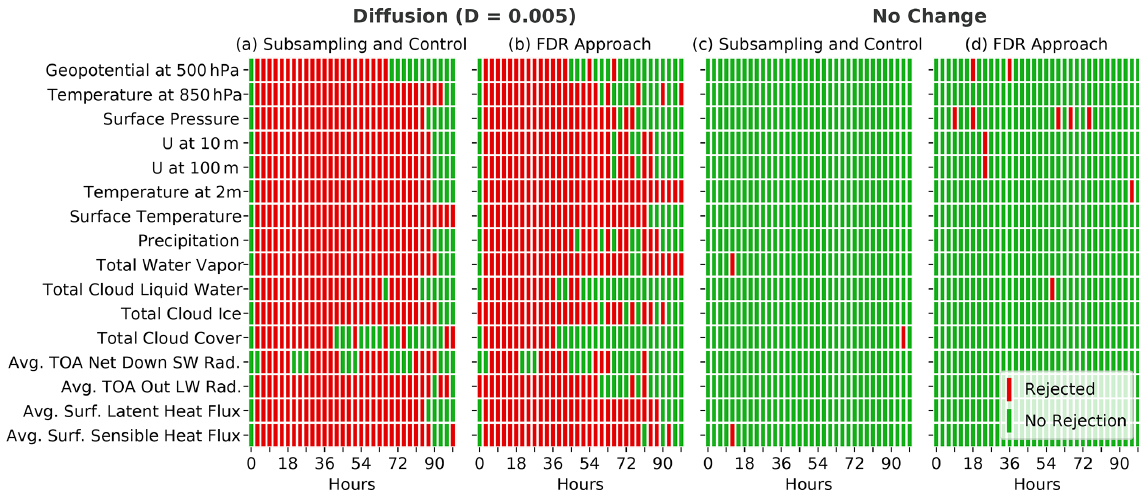
Figure 11. Comparison between our methodology, which uses subsampling ( n E = 100, n S = 50, m = 100) and a control ensemble, and an approach that uses only one comparison between all members of the two ensembles with n E = 100 in combination with the FDR correction and α FDR = 0 . 05. The Student t test was used for the local hypothesis testing in both cases. Panels (a) and (b) show the global rejections for the diffusion ensemble ( D = 0 . 005), whereas (c) and (d) show the respective rejections for an ensemble from an identical model (no change) to compare the false positive rates. Both methods show similar rejections, with a slightly higher number of false positives seen for the FDR